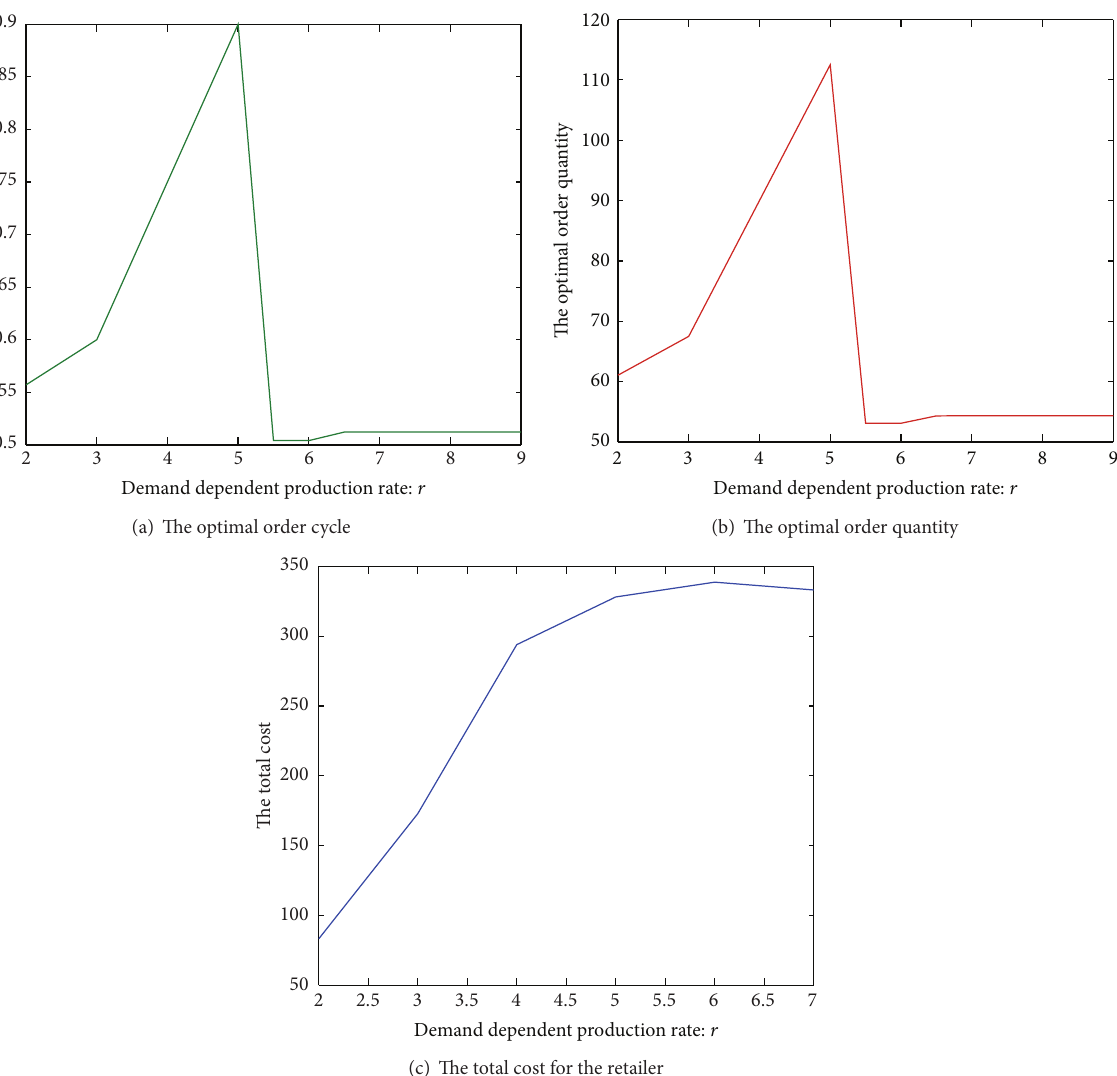
Figure 7: The impact of the changes of the parameter 𝑟 when 𝑀 ≥ 𝜇